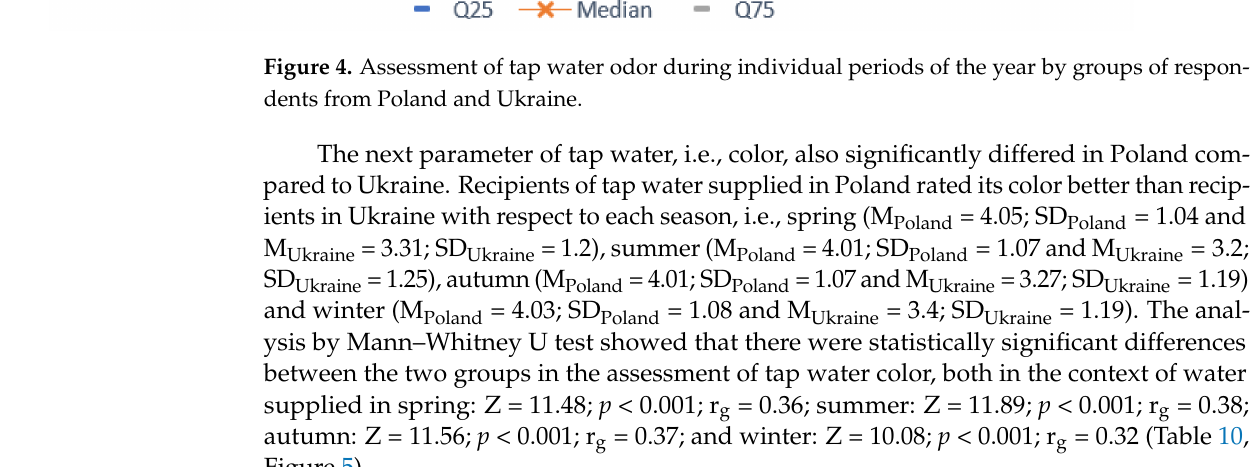
Mann– rg of Whitney U Test